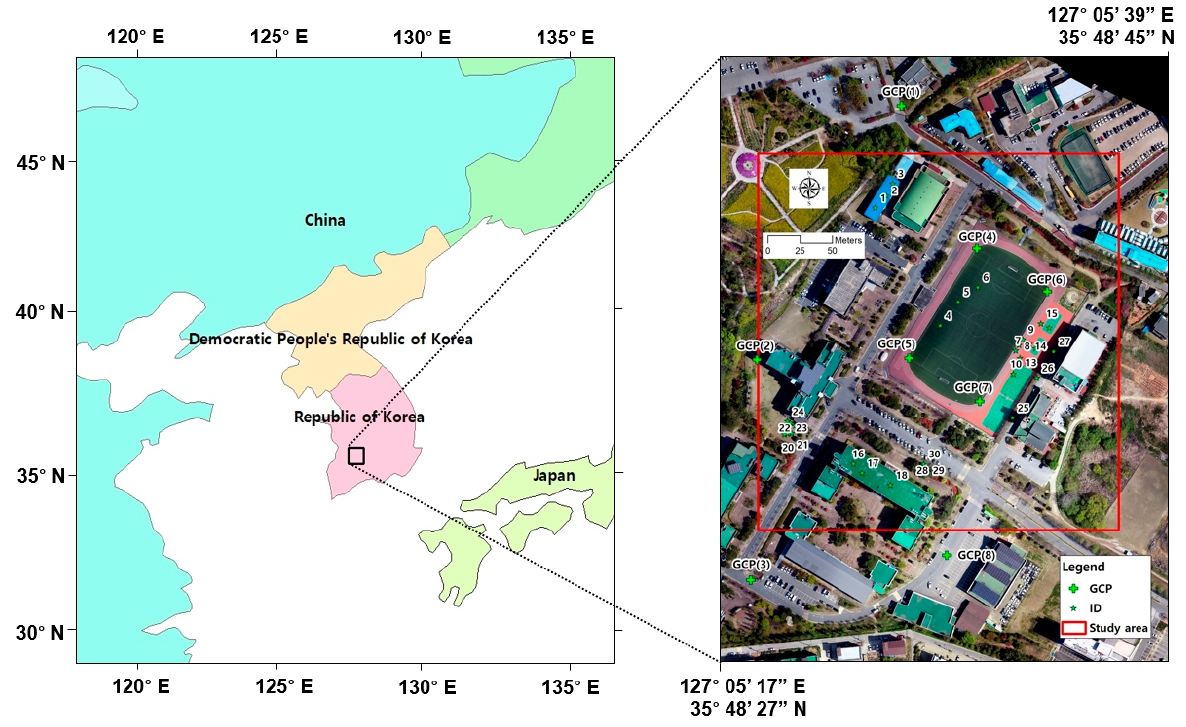
Figure 2. The study area.